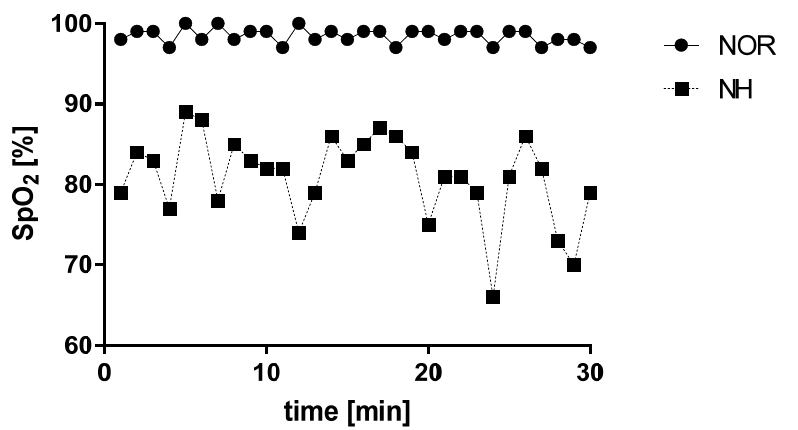
Figure 4. Effect of acute normobaric hypoxia exposure at FIO2 = 13% on blood saturation. Data are shown as the mean for the whole experimental group. NOR—normoxia; NH—normobaric hy- poxia.